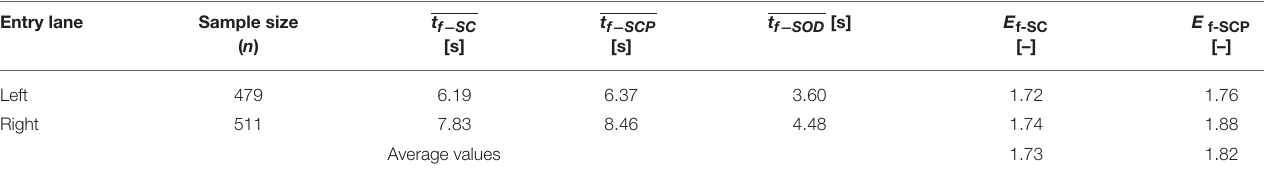
TABLE 5 | The passenger car equivalent factors for critical gaps for vehicle drivers on turbo roundabout entry